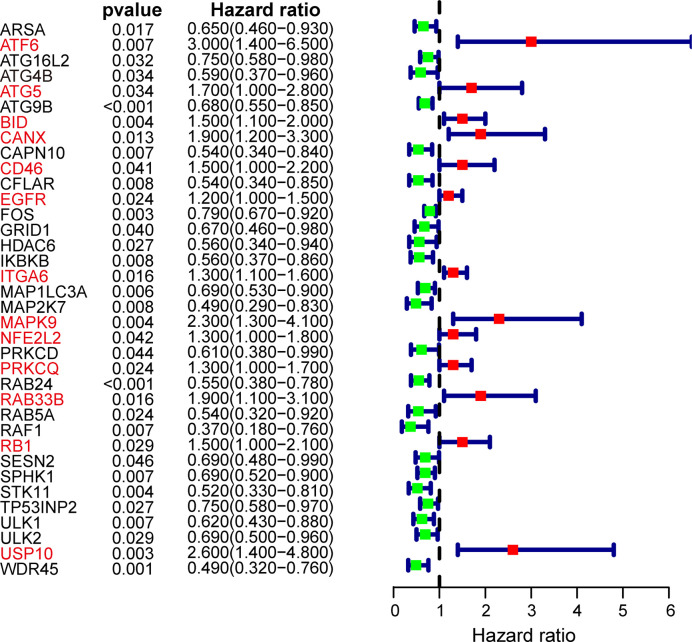
Forest plot of autophagy-related genes (ARGs) associated with OSCC survival. Genes in red font represent risk genes and in black font represent protective genes. Hazard ratios and 95% confidence intervals were calculated using univariate Cox regression analysis.